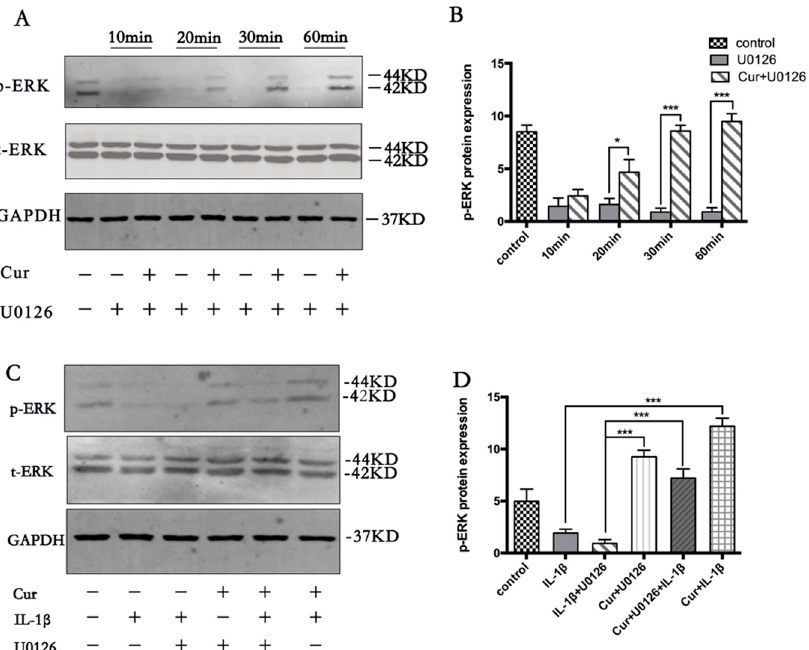
Figure 5. Curcumin reverses U0126-induced inhibition of extracellular signal-regulated kinases 1/2(ERK1/2) in primary chondrocytes. ( A ) p-ERK was visualized by western blot in U0126-treated chondrocytes. Serum-starved chondrocytes were preincubated with 10 µ m curcumin for indicated time points and co-treated with 10 µ m U0126 for 10 min, 20 min, 30 min, and 60 min. Curcumin pretreatment reversed U0126-induced ERK1/2 inhibition in a time-dependent manner. The pan ERK1/2 was not affected (and quantified in ( B )). ( C ) Effects of curcumin on IL-1 β -induced inhibition of mitogen-activated protein kinase (MAPK)/ERK1/2 pathway in primary chondrocytes in vitro. Serum-starved chondrocytes were pre-stimulated with 10 µ m curcumin alone for 4 h and then co-treated with IL-1 β (10 ng/mL) and/or 10 µ m U0126 for 24 h. Some cultures were left untreated and evaluated after 24 h. Results in ( B , D ) are expressed as means ± SD for experiments performed in triplicate. * p < 0.05, ** p < 0.01, and *** p < 0.001. Cur, curcumin.